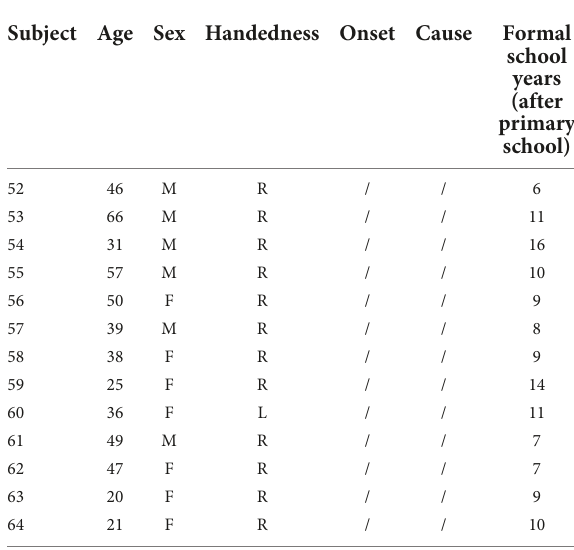
TABLE 1 Characteristics of